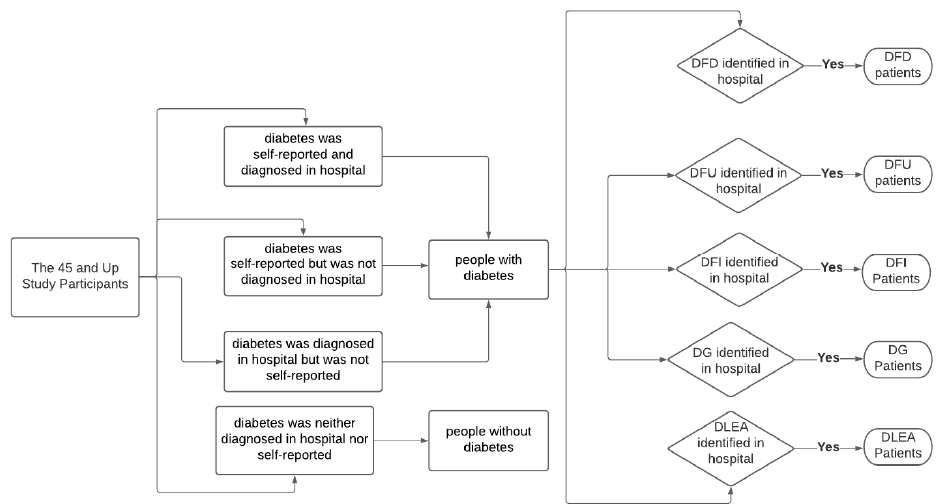
Figure 1. Identification of diabetes and different types of DFD and DLEA; DFD: diabetes-related foot disease, DFU: diabetic foot ulcer, DFI: diabetic foot infection, DG: diabetic gangrene, DLEA: diabetes-related lower extremity amputation.